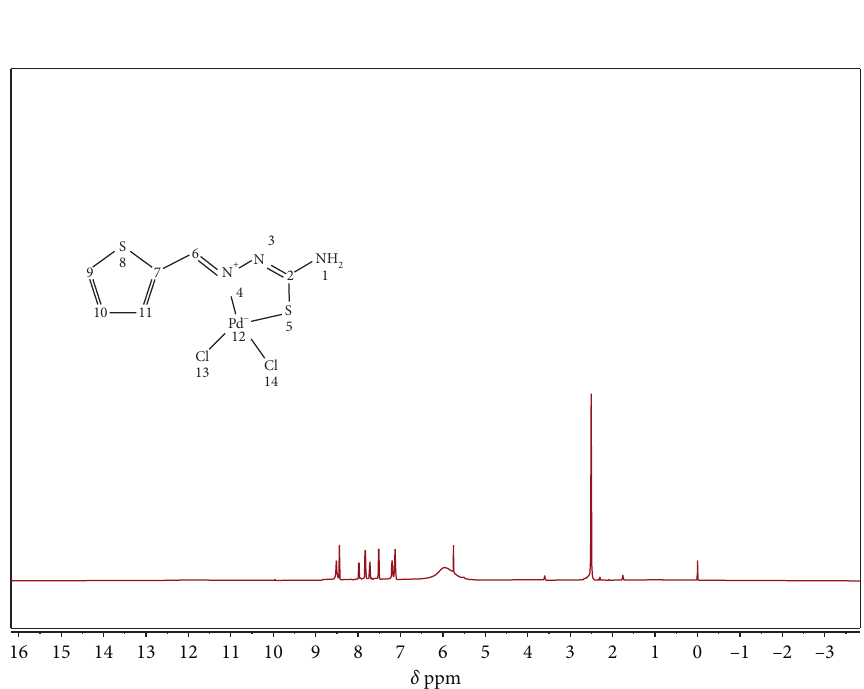
Figure 3: 1 H-NMR spectra for complex C1